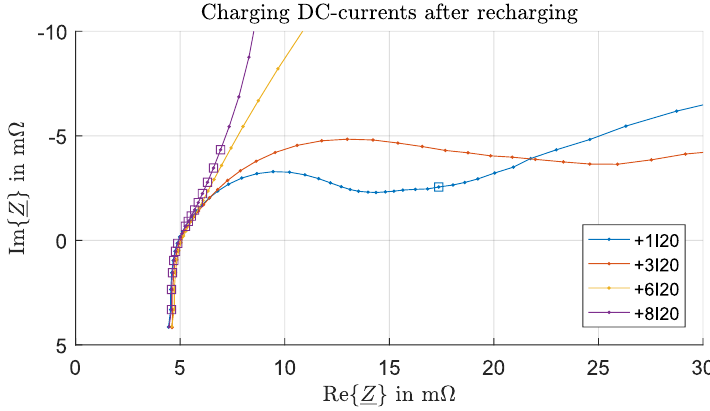
Figure 8. Impedance spectra with charging DC-currents measured on TC 1 of hard AK3.4 after 120FCE at the end of cycling phase and after recharging.